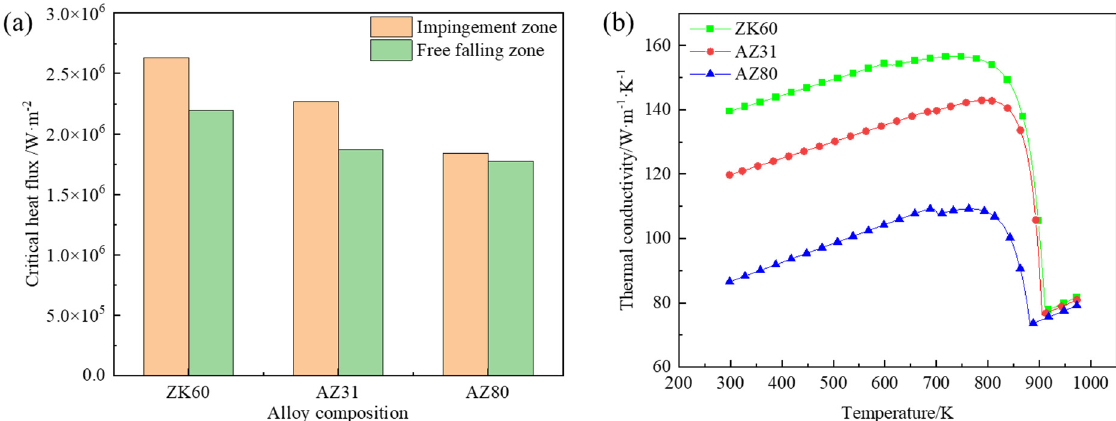
Figure 8. Critical heat flux ( a ) and thermal conductivity ( b ) of different